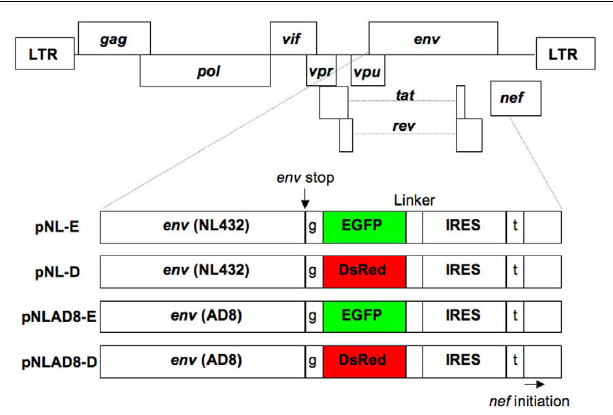
FIGURE 1 | Structure of the proviral DNA. The pNL432-based proviral clones encoded EGFP (pNL-E) or DsRed (pNL-D) for X4-tropic HIV-1 NL-E or HIV-1 NL-D , respectively, and the pNLAD8-based proviral clones encoded EGFP (pNLAD8-E) or DsRed (pNLAD8-D) for R5-tropic HIV-1 NLAD8-E or HIV-1 NLAD8-D , respectively. EGFP or DsRed was not expressed as a fusion protein with Env due to the insertion of a single base after the Env stop codon. Nef was also independently expressed under the control of IRES. t (Thymine) and g (guanine) are additional DNA sequences.